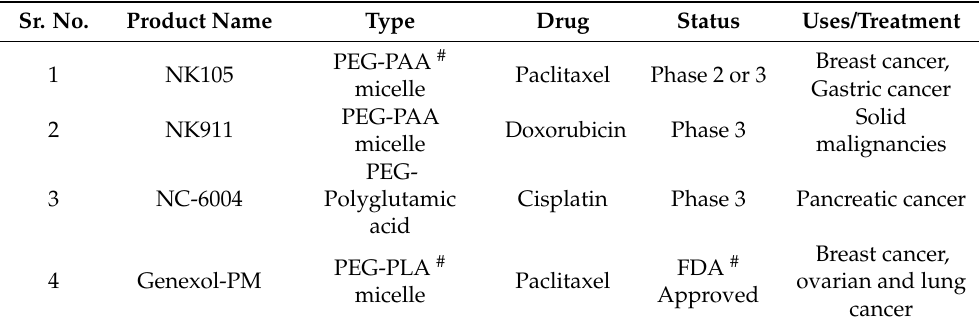
Table 3. Polymeric micelle for cancer therapy in clinical trial or uses. Reproduced with permission from reference